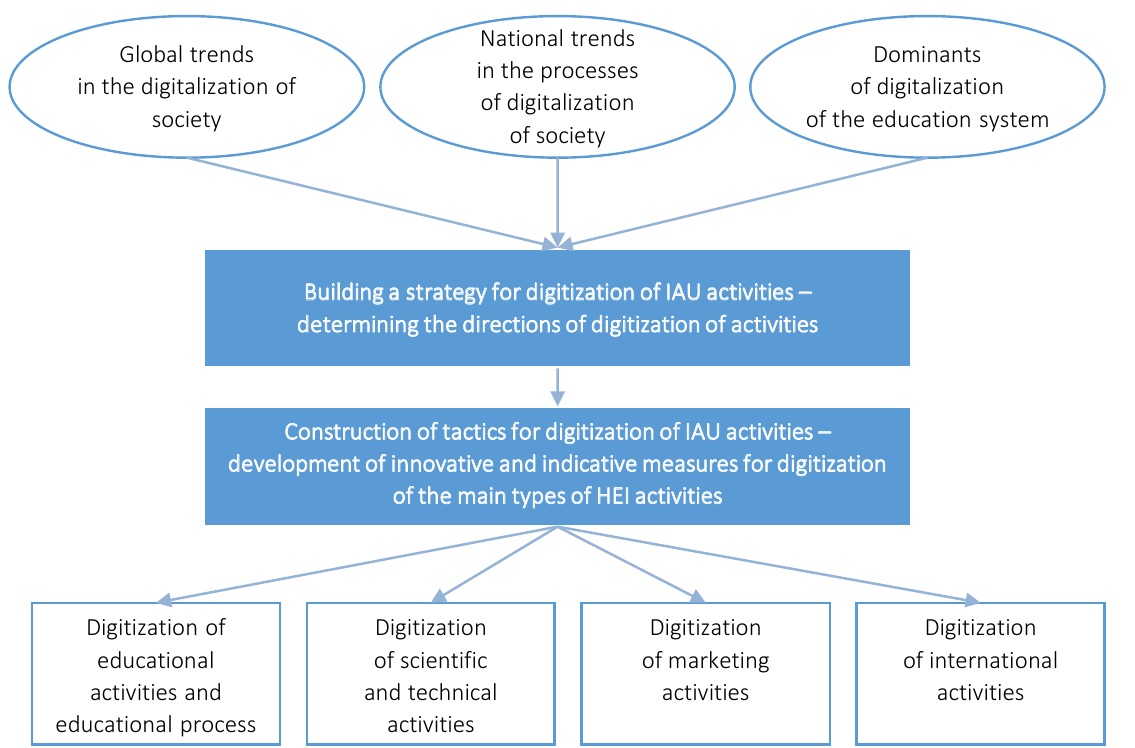
Figure 6. Components of the digitalization strategy of an innovative-active university